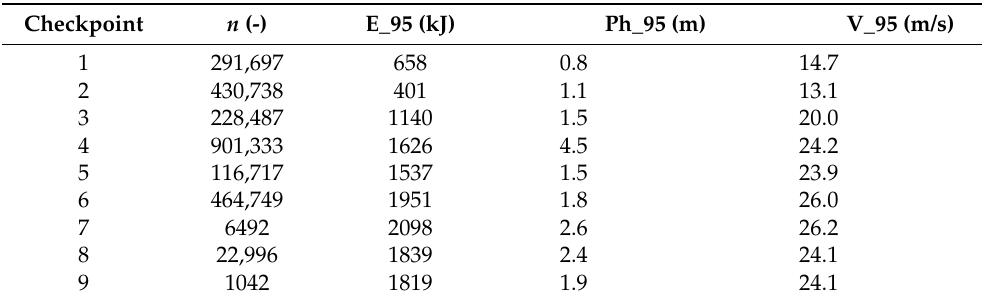
Table 3. Summary of Rockyfor3D simulations outputs in the FPOS scenario. For each checkpoint, the table reports: n , the total number of registered passages of falling rocks; E_95, the 95th percentile of the energy of registered falling rocks; Ph_95, the 95th percentile of passing height values recorded at the checkpoint; V_95, the 95th percentile of the speed of registered falling